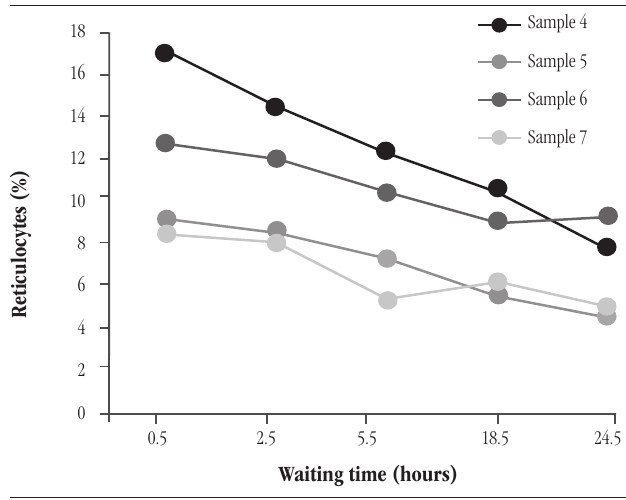
figurE 6 – Reticulocyte count (%) according to the waiting time (hours) for reading samples from patients with